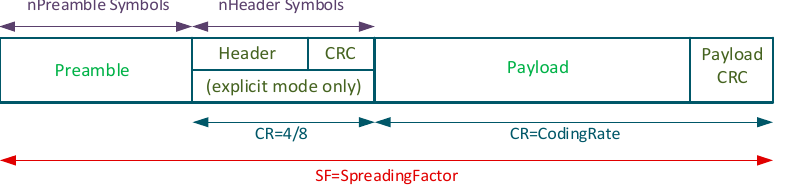
Figure 1. LoRa package format.